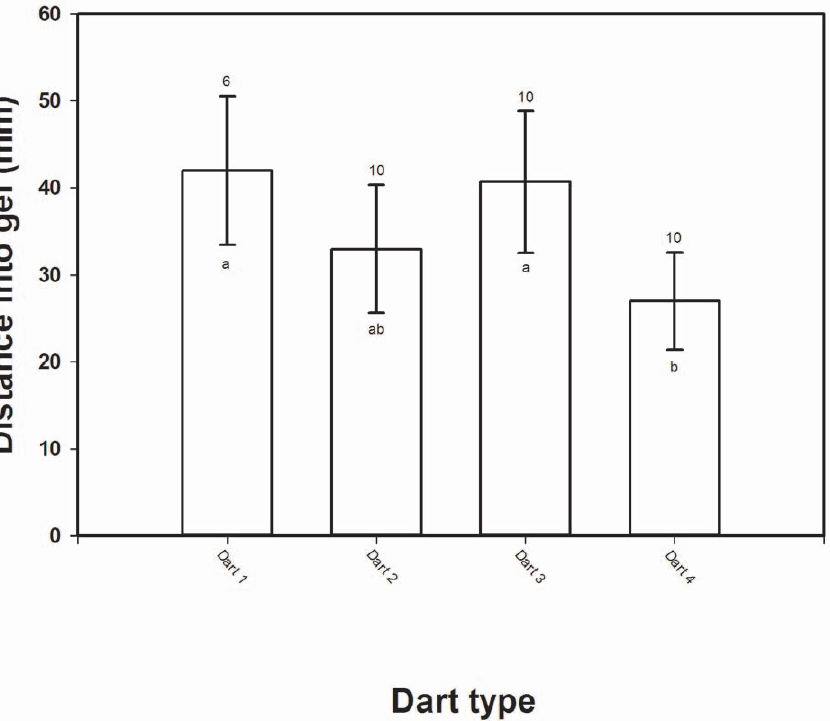
Figure 3. A comparison of depth of penetration for 4 prototype darts used to remotely inject Passive Integrated Transponder tags (PIT) into a gelatin block. Mean ( 6 SD bars) depth PIT penetrated the gelatin block by the 4 prototype darts. Number above bars is sample size and similar letters below bars indicated no difference in depth PIT penetrated the gelatin block at P , 0.05.